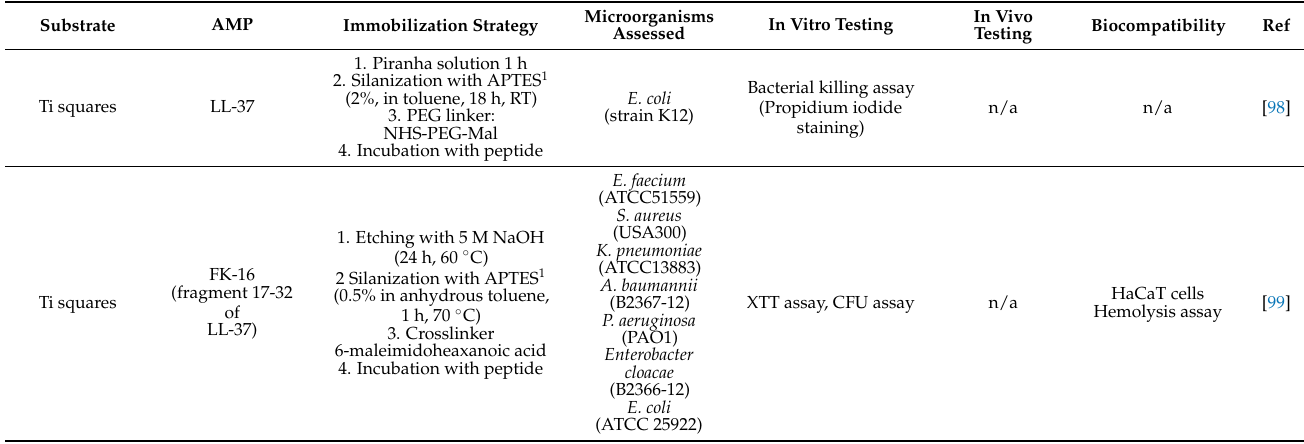
Table 1. Overview of AMPs’ immobilization-strategies onto Ti surfaces through either silanization or polymer brushes, and their biological